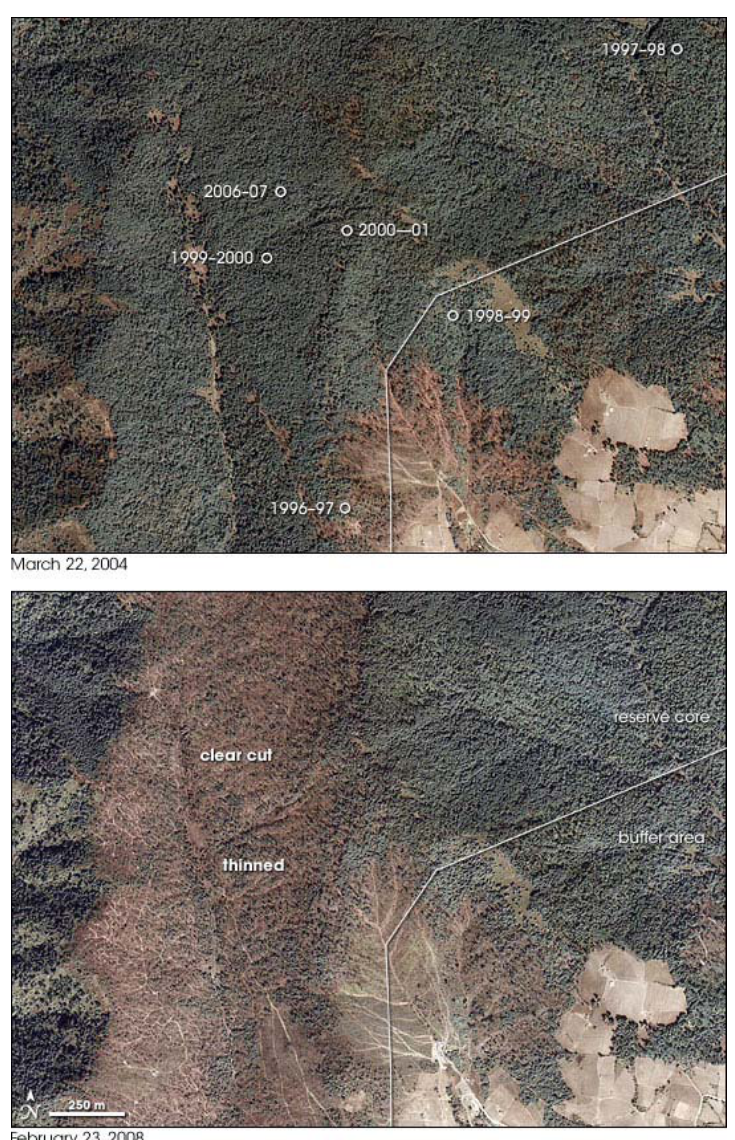
Figure 3. Aerial photographs of part of the core and buffer regions of a Monarch Preserve in Mexico in 2004 (top) and 2008 (bottom), showing loss of forest in the core area. The top figure also shows the locations of overwintering sites in different years and clearly indicates that these areas move. The size of the circles indicating overwintering sites are not scaled to fit different sizes of overwintering sites in different years. Taken from NASA